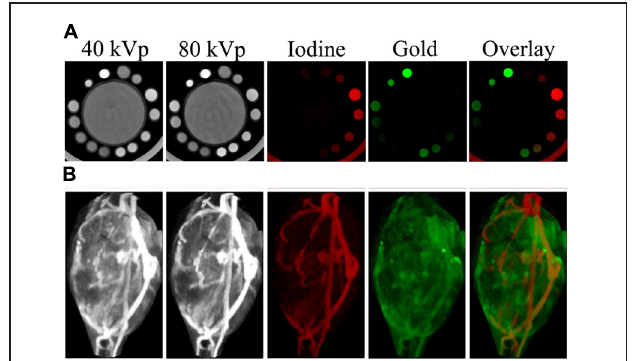
FIGURE 13 | Dual energy micro-CT material decomposition. (A) , In vitro phantom consisting of a large tube of water surrounded by vials containing gold, iodine, or a mixture of the two. (B) , In vivo imaging of gold nanoparticles and iodine-containing liposomes within a mouse soft tissue sarcoma. The iodine (shown in red) and gold (shown in green) maps are the result of dual energy decomposition. In both cases, the decomposition was able to successfully differentiate the signals from the gold and iodine contrast